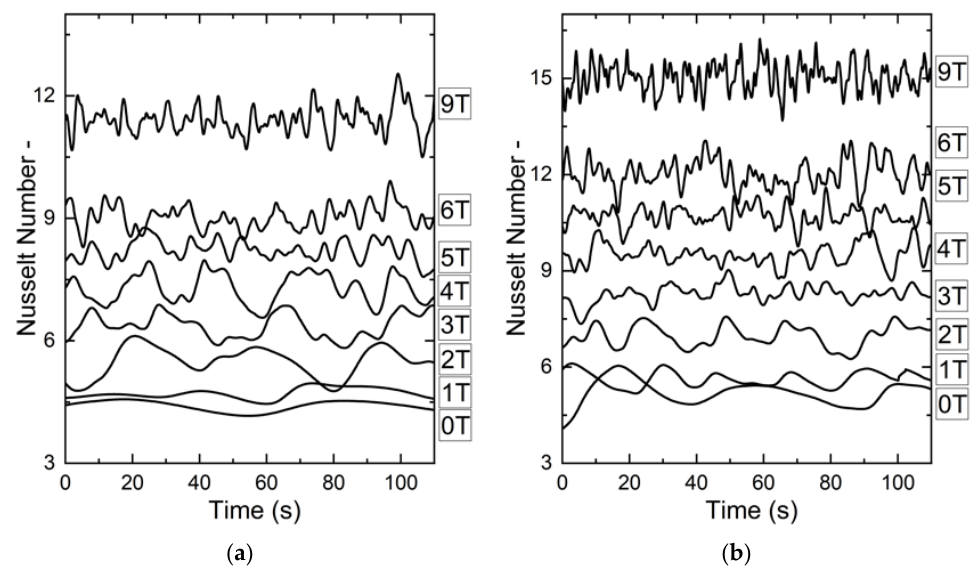
Figure 19. Changes of the Nusselt number with time for the numerical case with ( a ) Δ T = 5 °C and ( b ) Δ T = 11 °C . For the larger temperature difference (Figure 19b) the same tendencies can be ob- served, with the exception that the significant influence of the magnetic field induction on the heat transfer in the system is already visible for the first two cases b 0MAX = 0T and 1T— the mean value of the Nu number changes from 5.12 to 5.55. Also, the oscillatory character of the Nusselt number in time can be seen for smaller values of the magnetic induction,